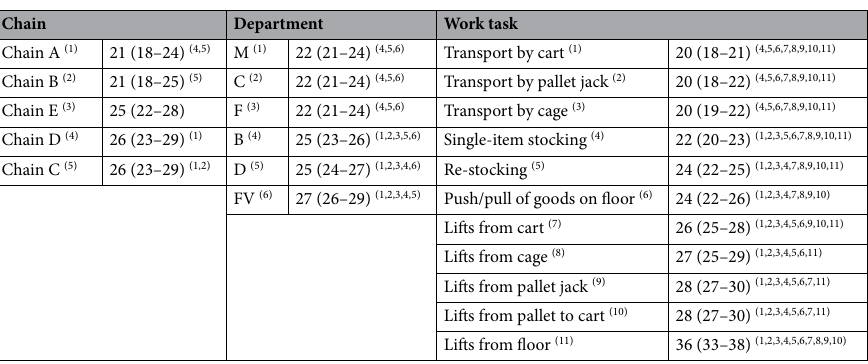
Table 6. Low-back muscular workload during supermarket stocking for chains, departments, and work tasks presented as least square means (LSM) with 95% confidence intervals of the 95th percentile rank of nRMS (% nRMS (95% CI)). n = 75 supermarket workers. B bread, C colonial, D dairy, F frozen goods, FV fruit and vegetables, M meat. Significant differences (p < 0.05) between conditions are indicated with numbers in